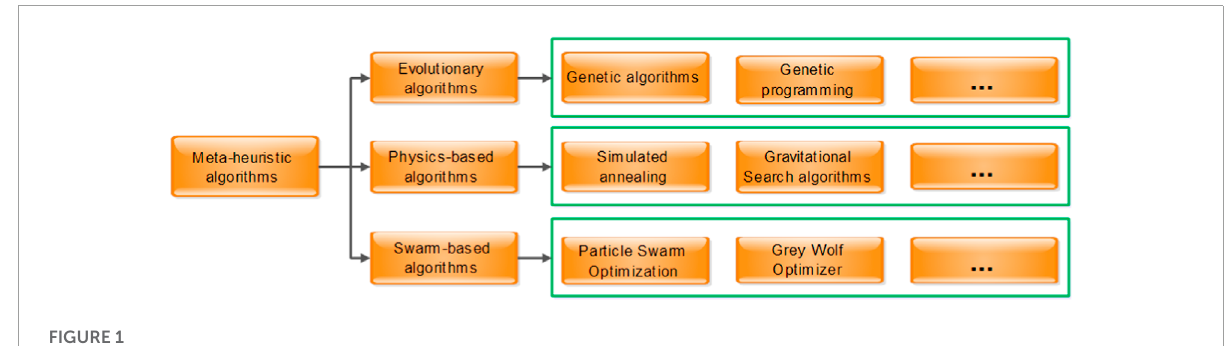
FIGURE 1 Classification of meta-heuristic